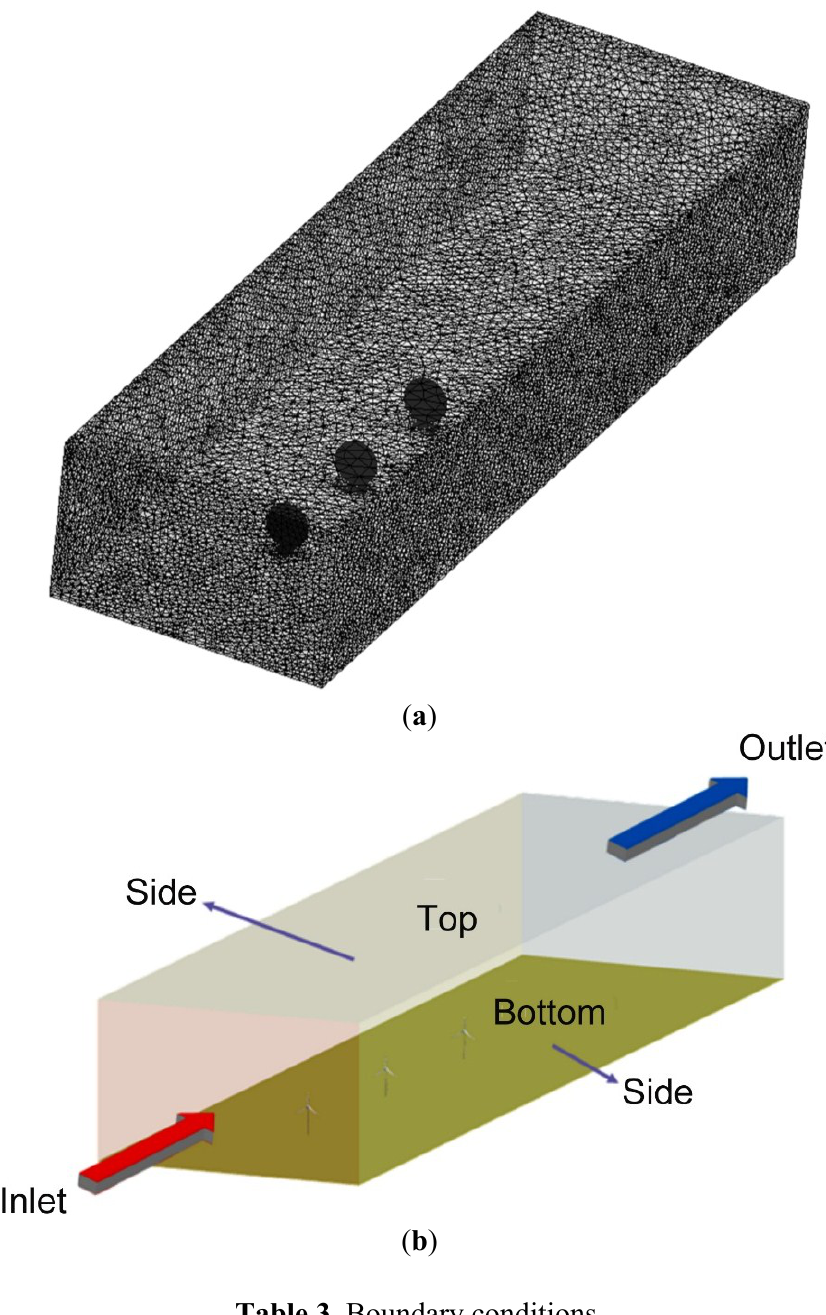
Table 3. Boundary